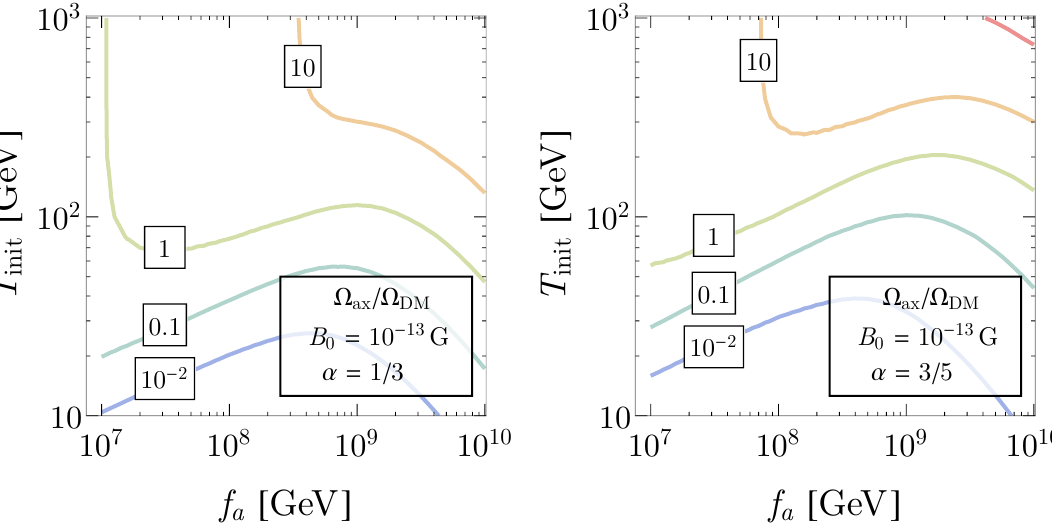
Figure 10 . Contour plots of Ω ax / Ω DM as a function of f a and T init for B 0 = 10 − 13 G today. The contours are labelled by the value of Ω